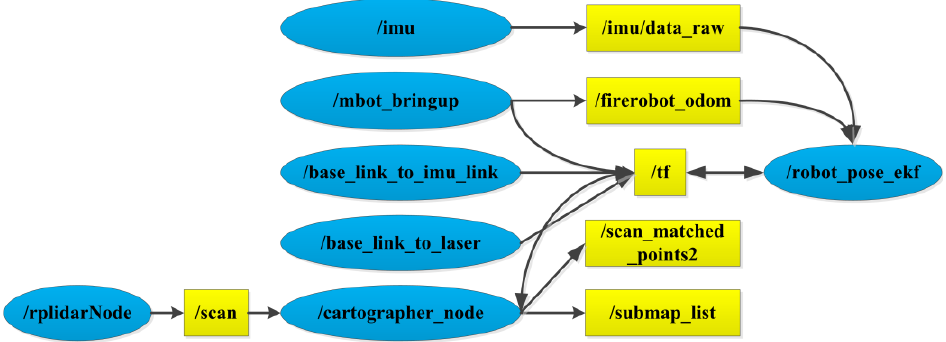
Figure 13. ROS node diagram of the Cartographer map construction system.